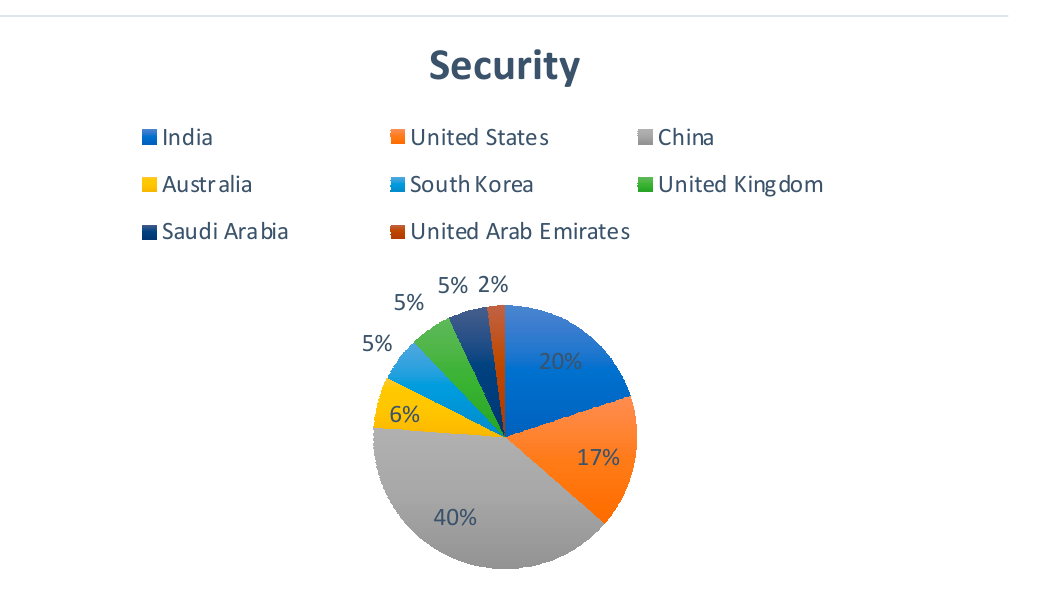
Figure 11. Region-specific publication distribution for the impact of Blockchain–Cloud integration on Cloud Security.